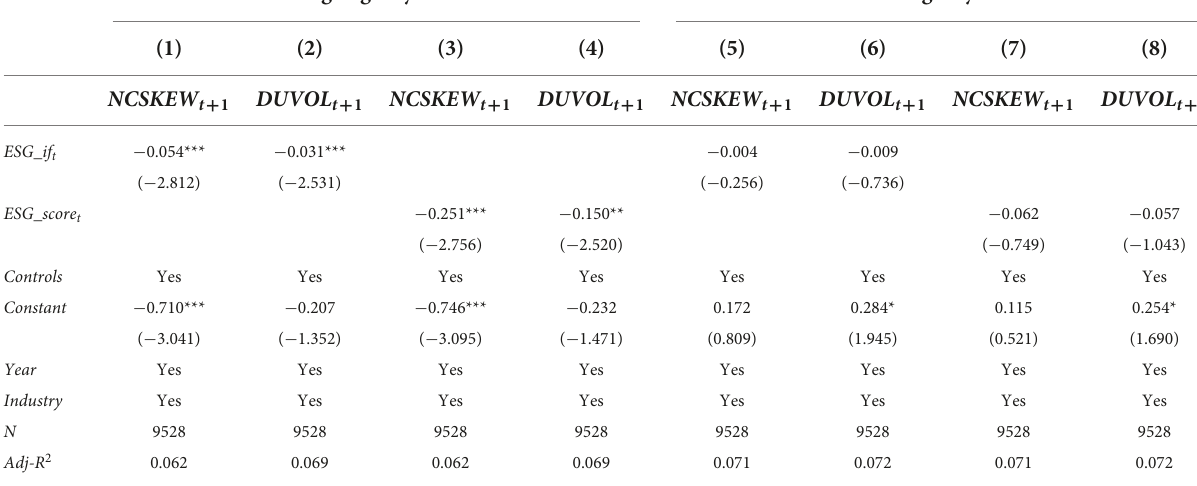
TABLE 8 Agency costs.